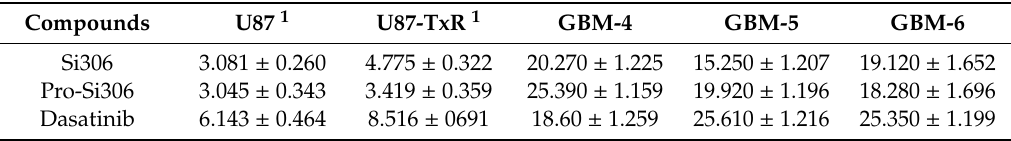
Table 1. Sensitivity of glioblastoma (GBM) cells to Src tyrosine kinase (Src) inhibitors after 72 h treatment expressed as IC 50 values ( µ